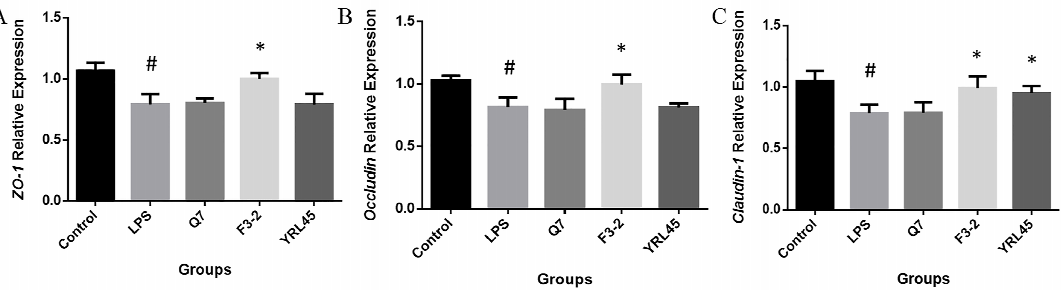
Figure 6. Effect of L. plantarum Q7, L. plantarum F3-2 and L. plantarum YRL45 on the gene expression of ZO-1 ( A ), Occludin ( B ) and Claudin-1 ( C ) in Caco-2 cells. # p < 0.05: LPS group compared with control group. * p < 0.05: strain groups compared with LPS group.